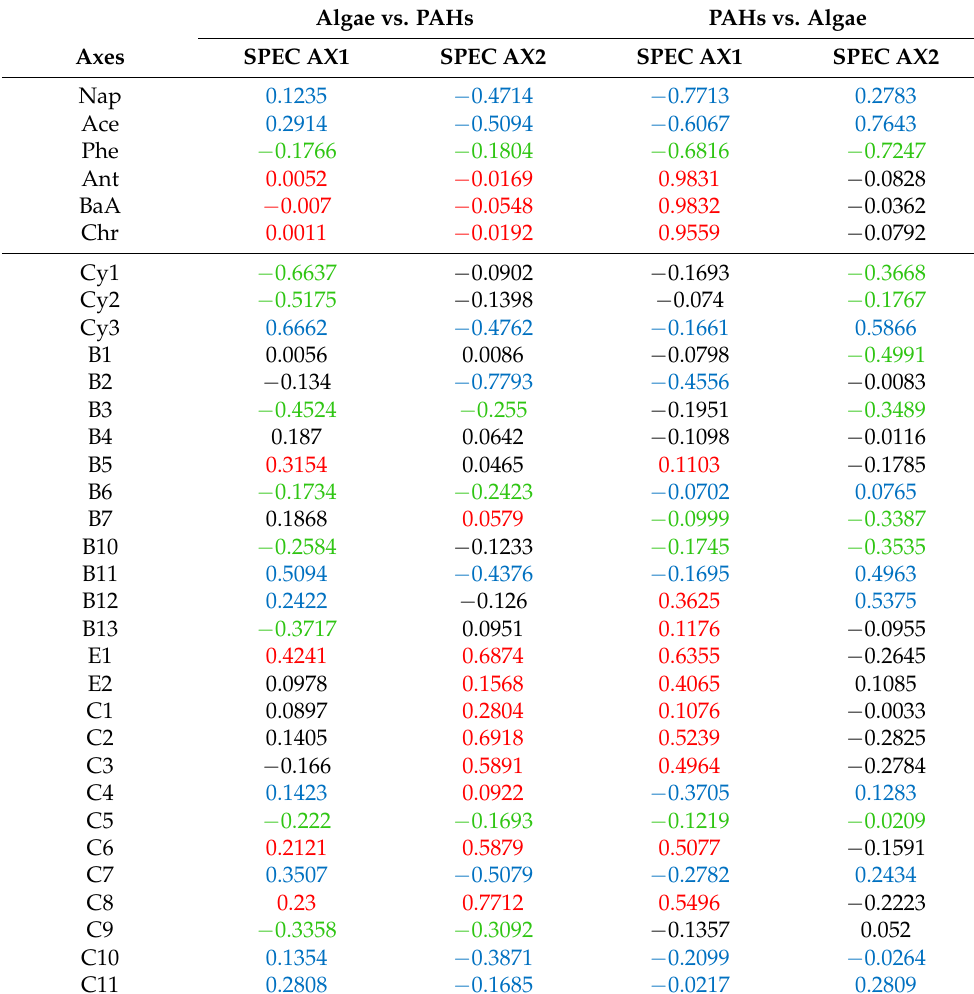
Table 3. Correlation coefficients among PAHs, algae, and RDA ordination axes. Algae vs. PAHs PAHs vs. Algae Axes SPEC AX1 SPEC